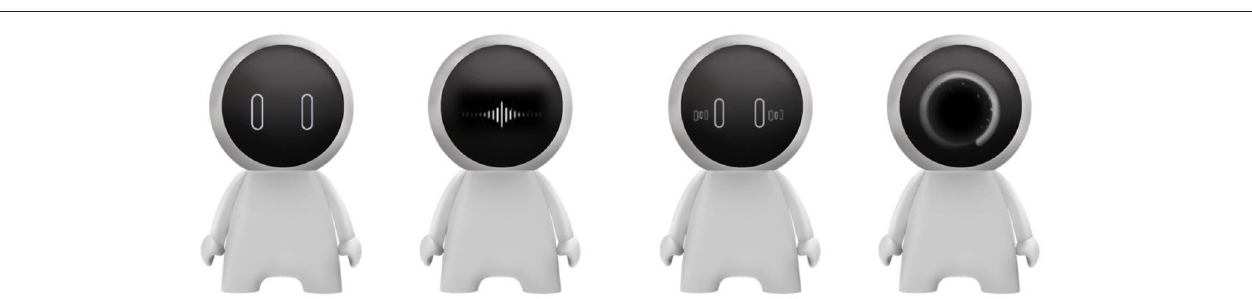
FIGURE 3 | Stimuli creation process.